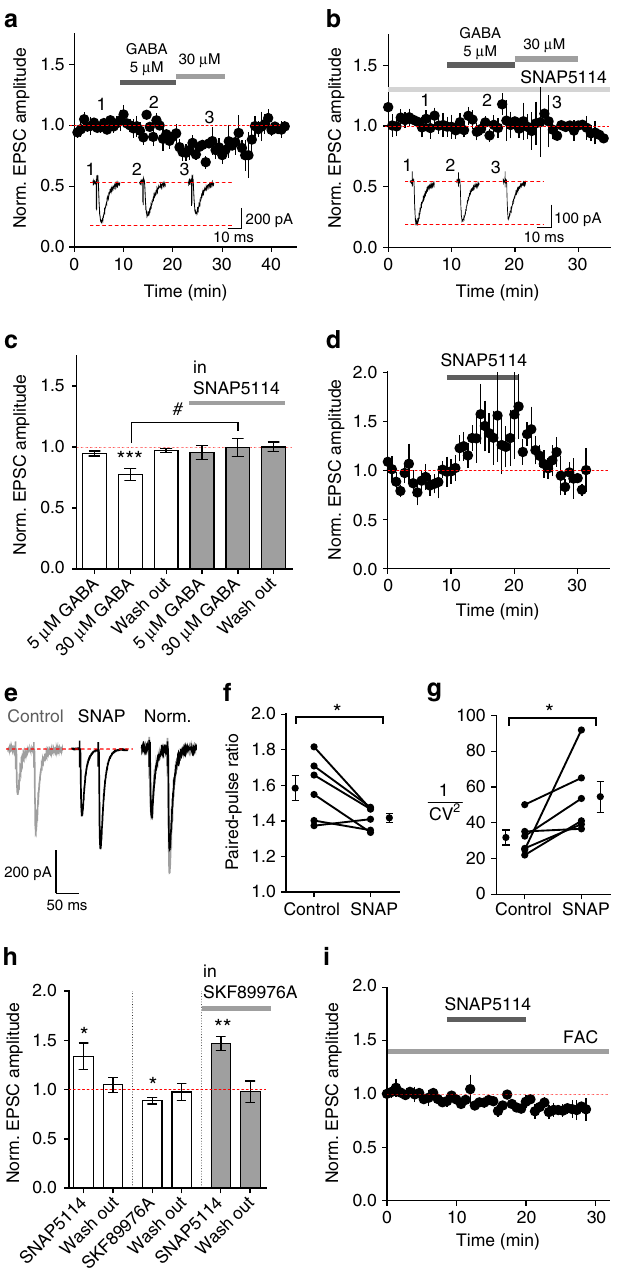
Figure 1 | GABA inhibits glutamatergic signalling in a GABA receptor-independent manner through GAT-3 activation. ( a , b ) The effect of GABA on EPSC amplitude ( n ¼ 7 cells from 2 animals for 5 m M GABA, n ¼ 4 cells from 2 animals for 30 m M GABA) is prevented by pre-incubation in the GAT-3 inhibitor, SNAP5114 (100 m M; n ¼ 6 cells from 3 animals). Inserts : Ten EPSCs averaged at indicated time points. ( c ) Summary data for EPSC amplitude. ( e ) Representative traces of EPSCs evoked in response to paired-pulse stimulation: SNAP5114 decreases the paired-pulse ratio ( f ) and increases 1/CV 2 ( g ) ( n ¼ 6 cells from 3 animals). ( h ) Summary of normalized EPSC amplitude changes in the presence of GAT inhibitors (SNAP5114: n ¼ 7 cells from 6 animals; SKF89976A 30 m M: n ¼ 6 cells from from 3 animals). ( i ) Fluoroacetate (FAC; 5mM) abolishes SNAP5114- induced potentiation of EPSCs ( n ¼ 6 cells from 2 animals). (FAC also causes a slow rundown of EPSCs—possibly reflecting astroglia’s role in stable synaptic neurotransmission). Error bars represent s.e.m.’s * P o